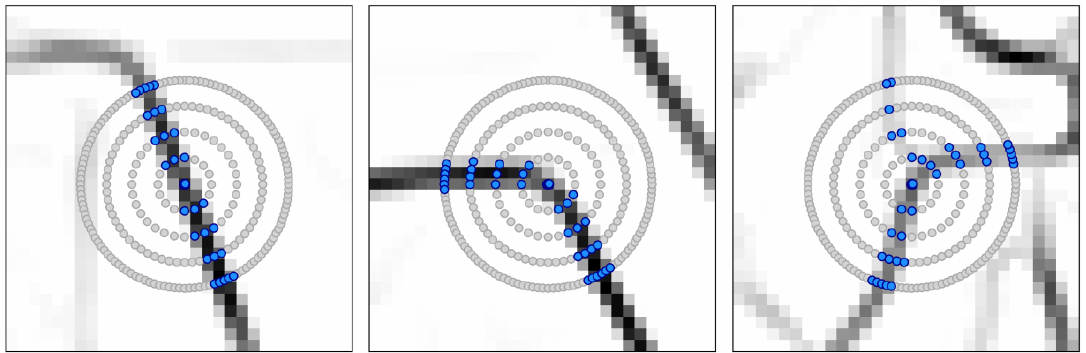
Figure 5. Examples for adaptive masking of vertices in the graph. Light grey points indicate removed points of the local graph, blue points represent those retained after masking.